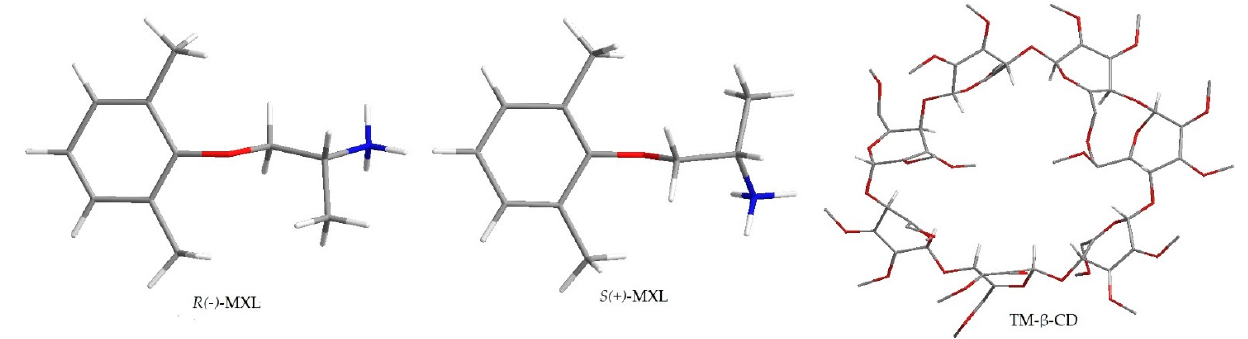
Figure 4. Energy-minimized models of MXL enantiomers and TM- β -CD (white—H, red—O, grey— C, blue—N).